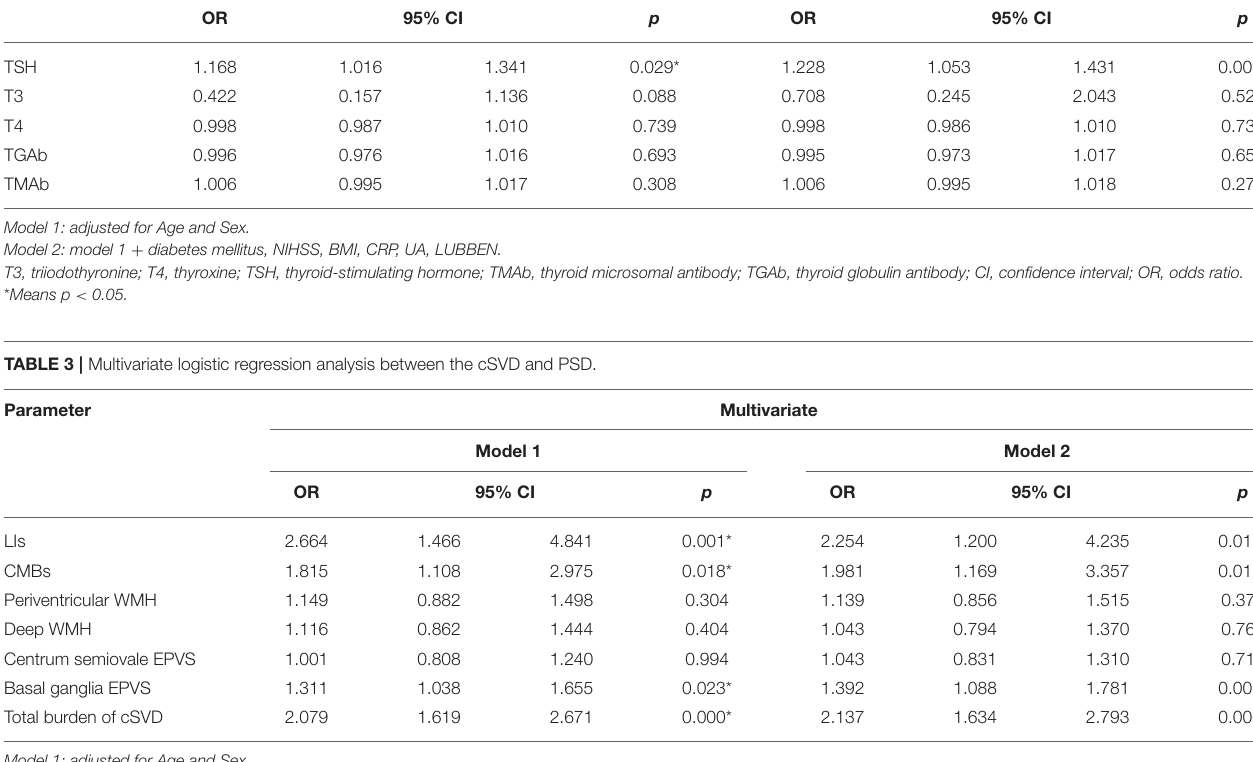
Basal ganglia EPVS